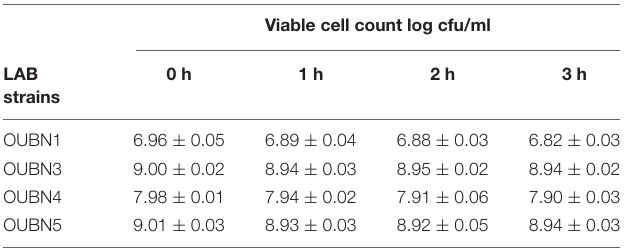
Frontiers in Microbiology |